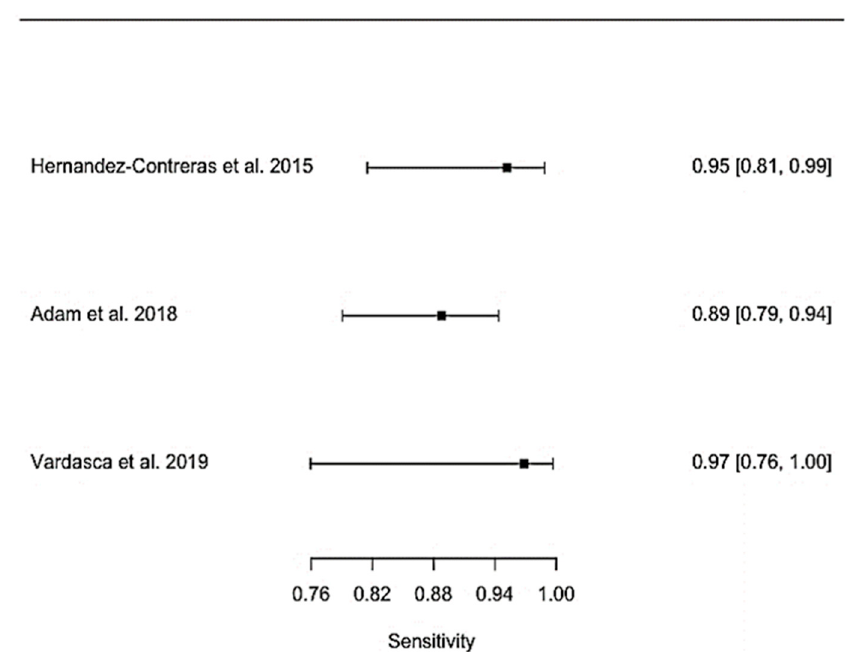
Figure A4. Forest plots for sensitivity for diabetic foot studies.